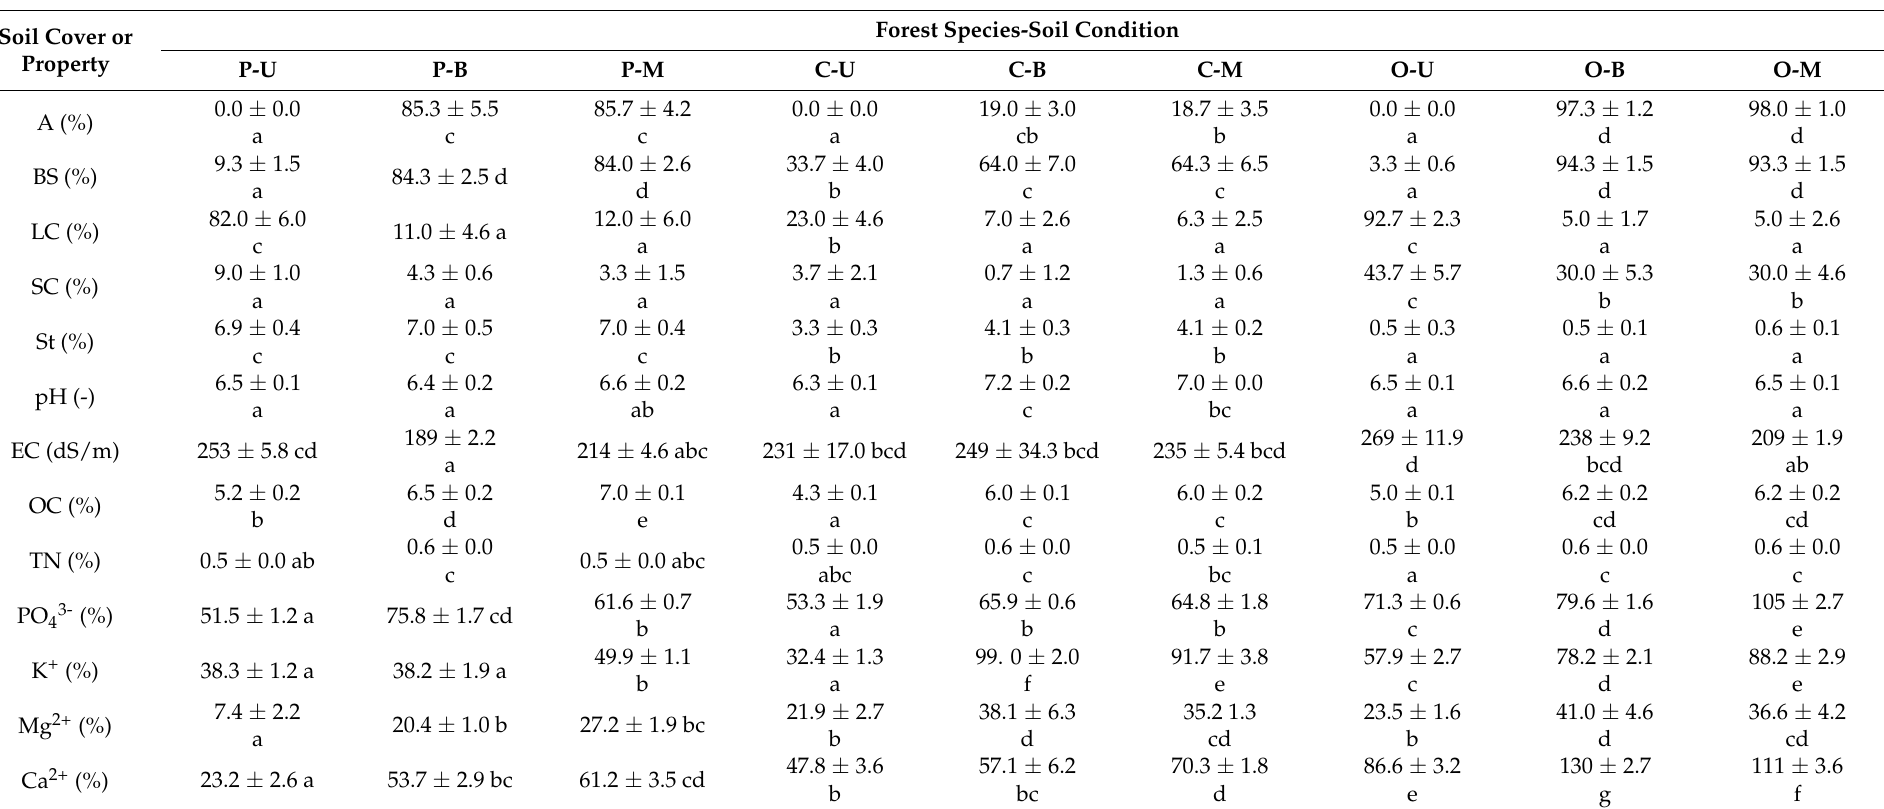
Table A1. Mean and standard deviation of the soil covers and properties in the experimental sites immediately after the prescribed fire and mulching treatment (Samo, Calabria, Southern